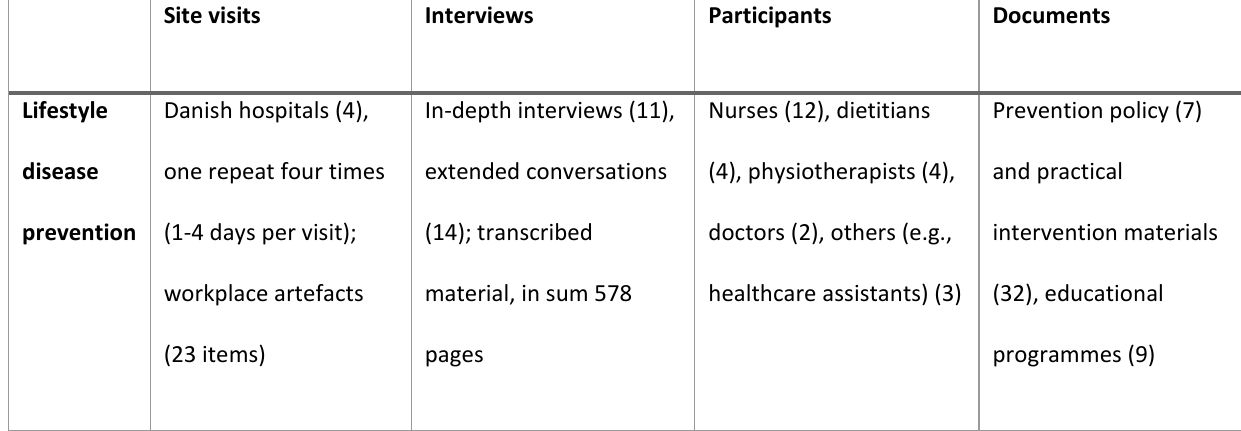
Table 1. Overview of data